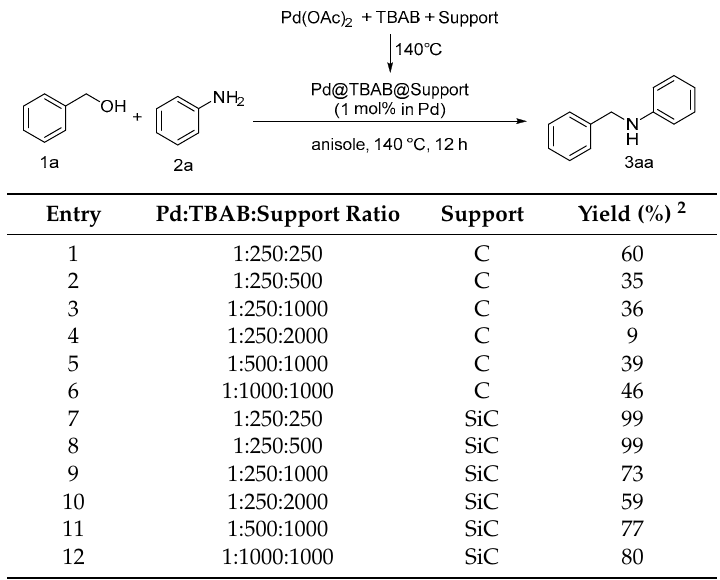
Table 3. N- Alkylation of amines with alcohols using a heterogeneous catalyst 1 .